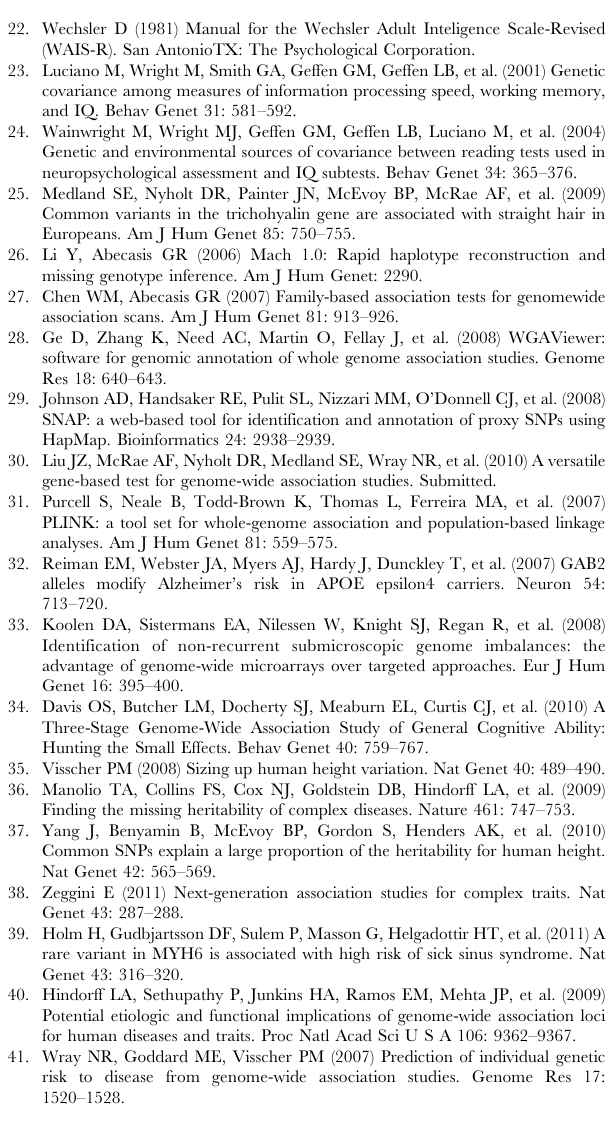
Table S1 Descriptive statistics for the different cohorts from which the educational attainment data